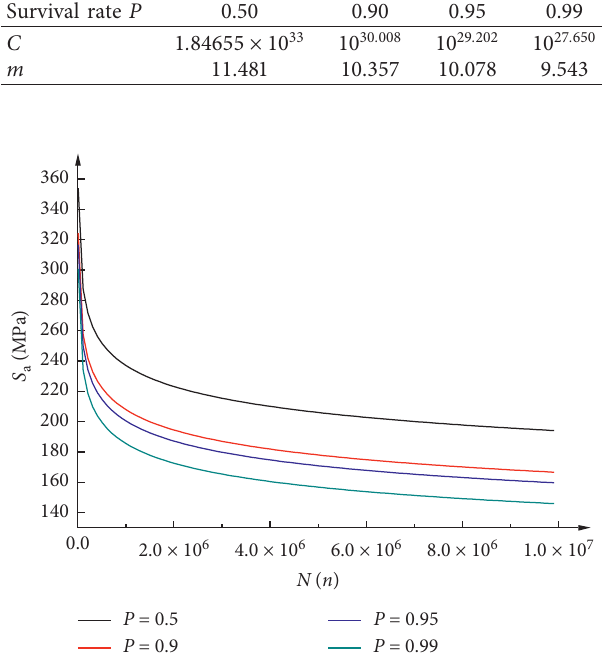
Figure 1: P-S-N curve of Q345